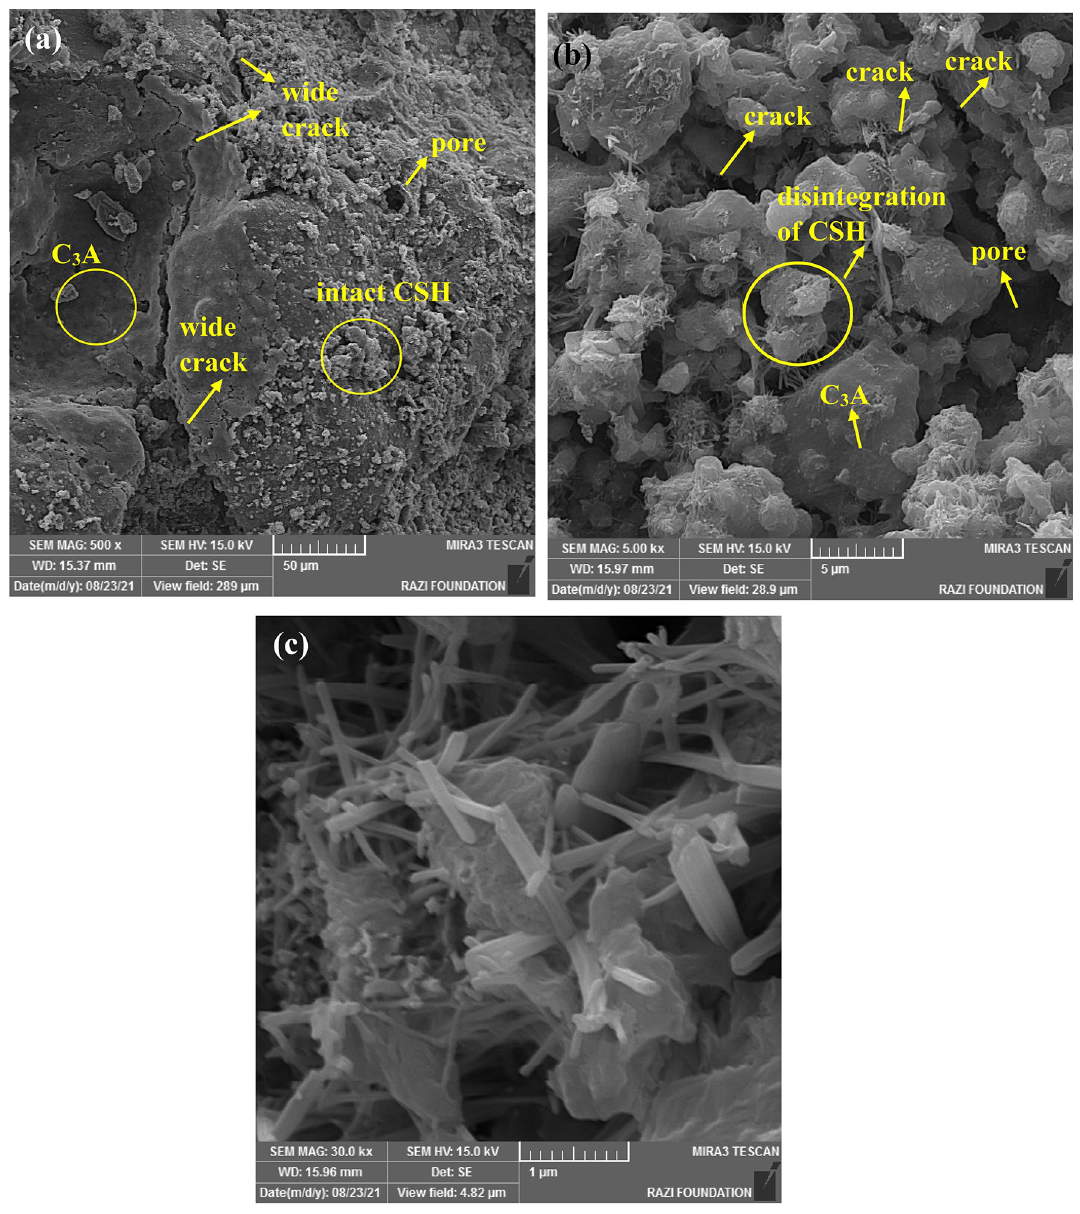
Fig. 16 The scanning electron microscope (SEM) images of mixture with 10% cement subjected to the 12th F-T cycle: a 500× magnification, b 5000× magnification, c 30,000×